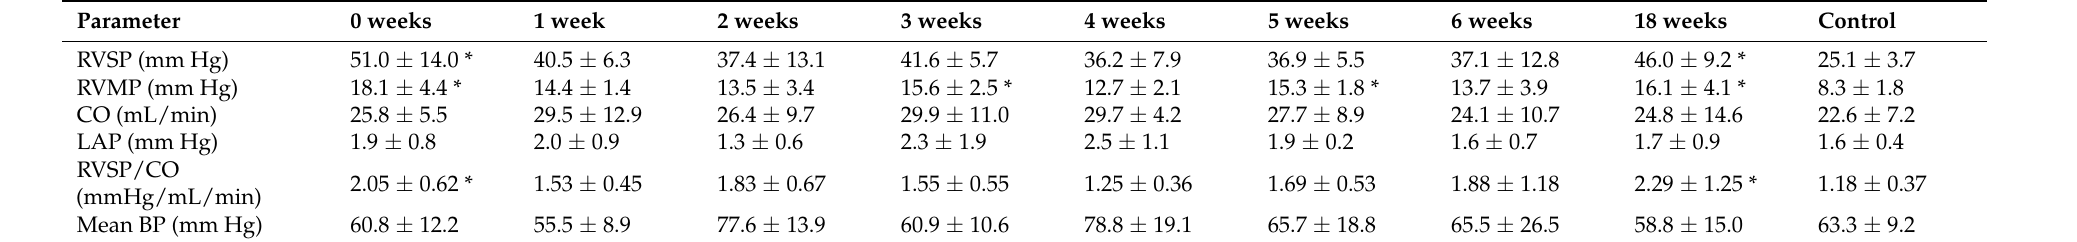
Table 1. Hemodynamic parameters in rat CTEPH model. n = 7 at each time point in CTEPH